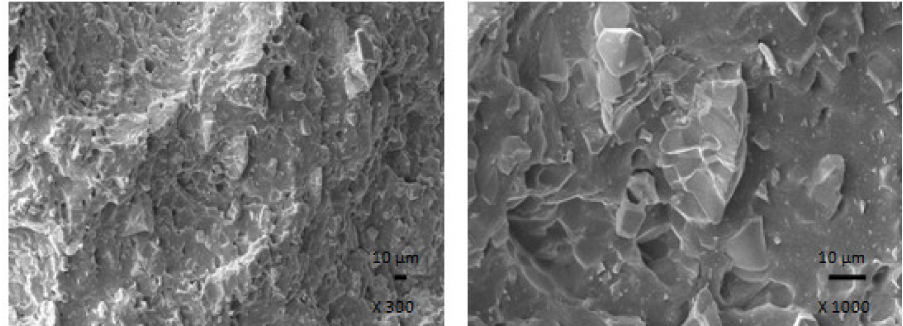
Figure 18. SEM images of hybrid CNT/ferrite composite containing 100 phr of